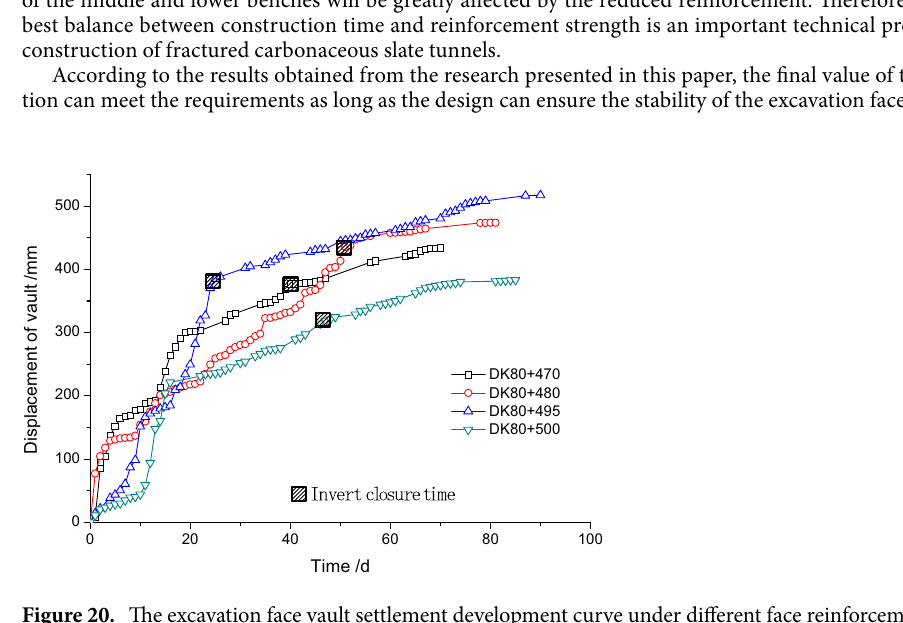
Figure 20. The excavation face vault settlement development curve under different face